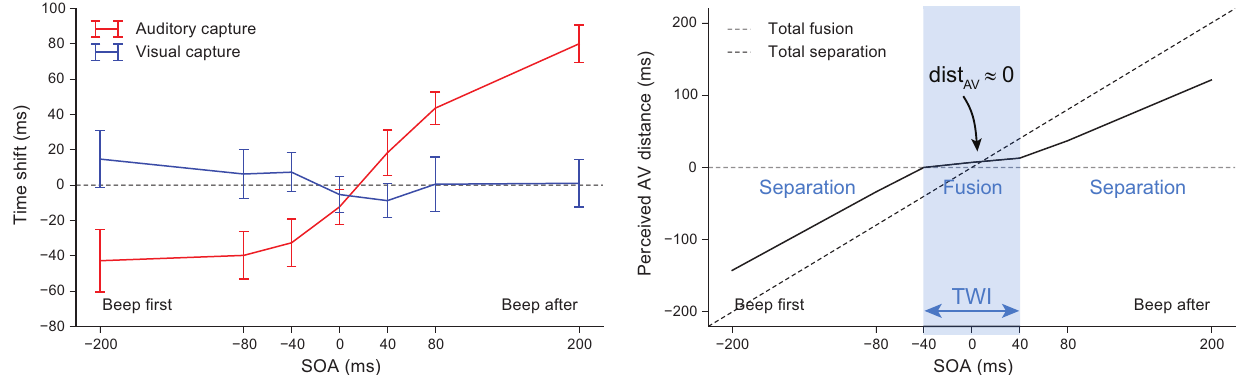
Fig 4. The perceivedAV distance. Time shifts producedby auditorycapture δ AC and visual capture δ VC with the same SOA sign convention, averagedacross participants (left plot) and the resulting estimationof the auditory-visual distancedist AV (right plot) . Error bars indicate inter- individualstandarderrors. The black and gray dashedlines on the bottom plot show the predictions for total fusion (dist AV = 0) or for total separation(dist AV = SOA), which are used to distinguish3 areas of AV interactionalong the SOA axis: separation, fusion and separation. The temporal windowof integration(TWI) corresponds roughlyto the [–40ms, +40ms]